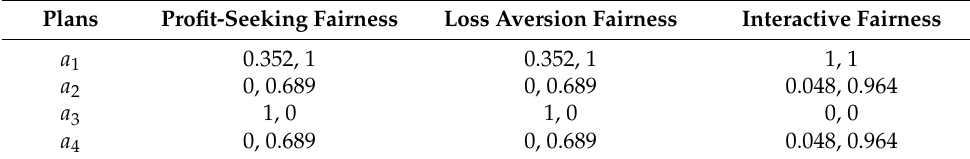
Table 12. The result of normatively processing original data.